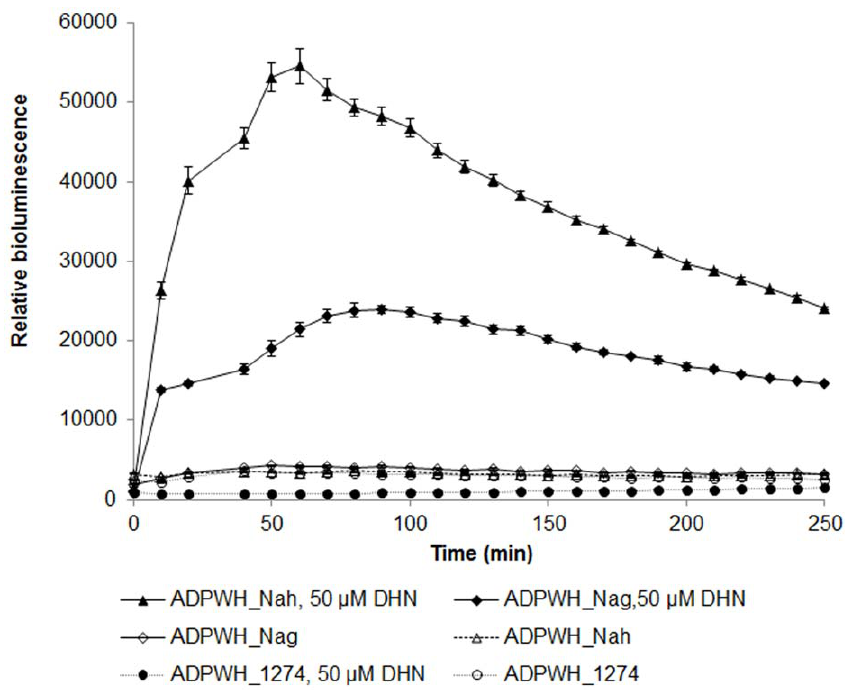
Figure 4. Bioluminescence of biosensor transducers incorporating DHN degradation genes. ADPWH_Nag containing a nag 2 gene cluster was rapidly activated to show bioluminescence after the addition of 50 m M DHN, confirming the function of the gene cluster. No bioluminescence was detected in the absence DHN. The negative control ADPWH_1274 did not respond to DHN. ADPWH_Nah containing a nah gene cluster was used as a positive